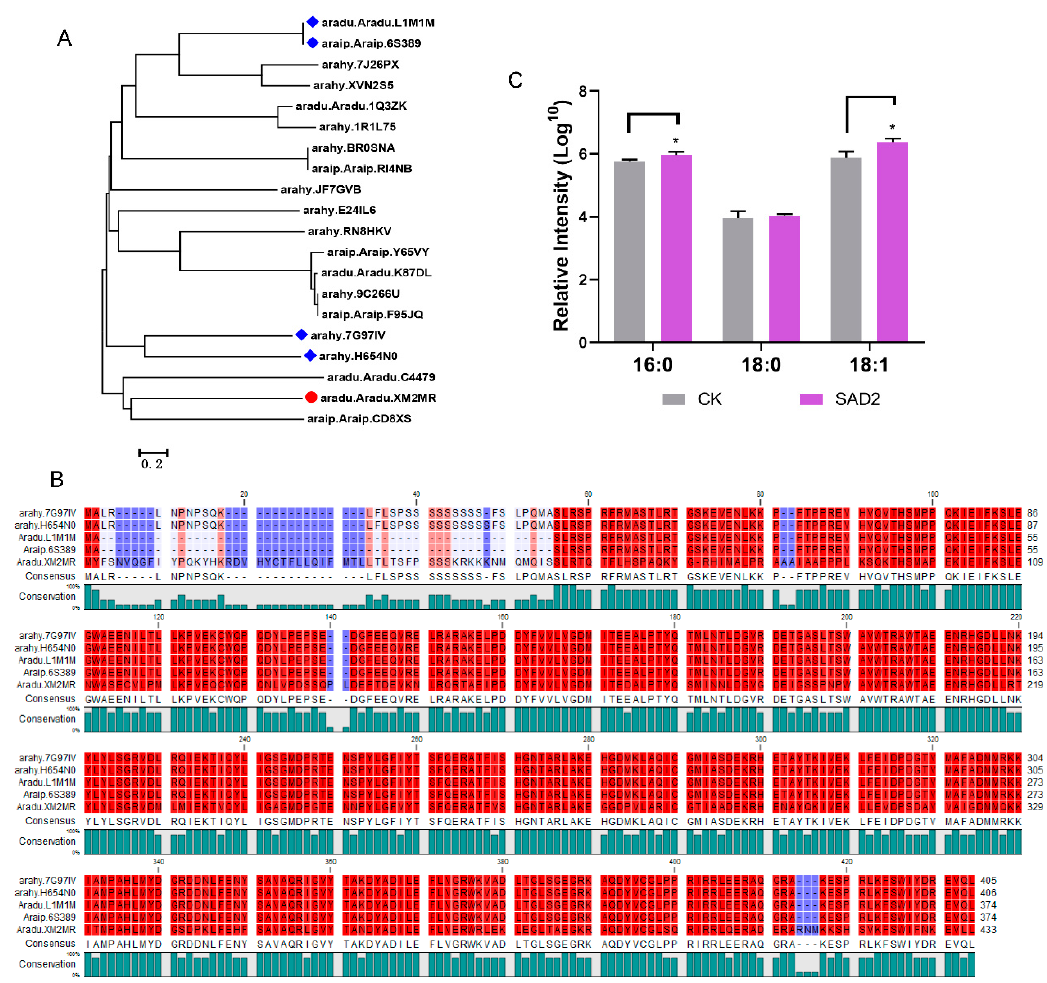
Figure 6. Sequence analysis of SAD2 ( Aradu.XM2MR ). ( A ) Comparative phylogenetic analysis of the SAD2 homologous proteins in peanut. The phylogenetic tree was generated by a Neighbor-Joining algorithm with the software MEGA6 (bootstrap test, 2000 replicates). Gene accession number referenced the peanut database (www. PeanutBase.org). ( B ) Protein sequence alignment of SAD2 ( Aradu.XM2MR ) by the software CLC sequence viewer 7. ( C ) Histogram displaying the relative intensity (log 10 ) of C16:0, C18:0, and C18:1 in yeast cells expressing SAD2 ( Aradu.XM2MR ), respectively. CK indicates empty vector pYES2. SAD2 indicates the pYES2- Aradu.XM2MR . Values shown are means ± SD of three biological replicates, and asterisks indicate a significant di ff erence as compared with the control group (* p < 0.05).